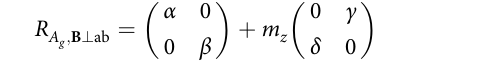
we would not expect to detect the A g phonon in xy polarization con fi gurations. A magnetic fi eld applied perpendicular to the ab plane that spin-polarizes the CrI 3 to the FM state, however, introduces off-diagonal tensor elements and breaks this expecta- tion, causing the polar plot to rotate as seen in Fig. 4a. Assuming there are minimal changes between the monoclinic (C 2h ), 10 L CrI 3 and the hexagonal point group of the monolayer (D 3d ), then β ≈ α + Δ and δ ≈ − ( γ + Δ ′ ), where Δ and Δ ′ are small corrections.